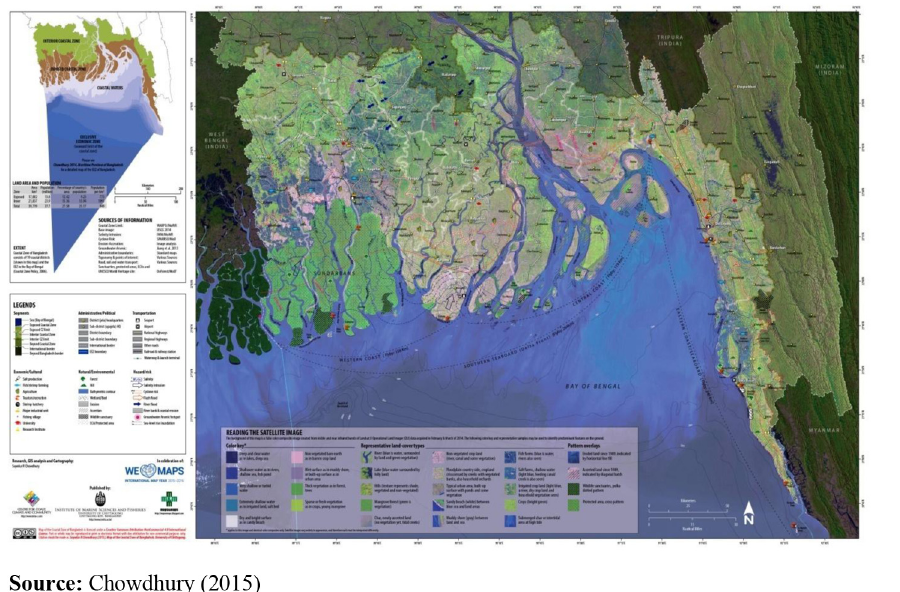
Figure 1. Map of the